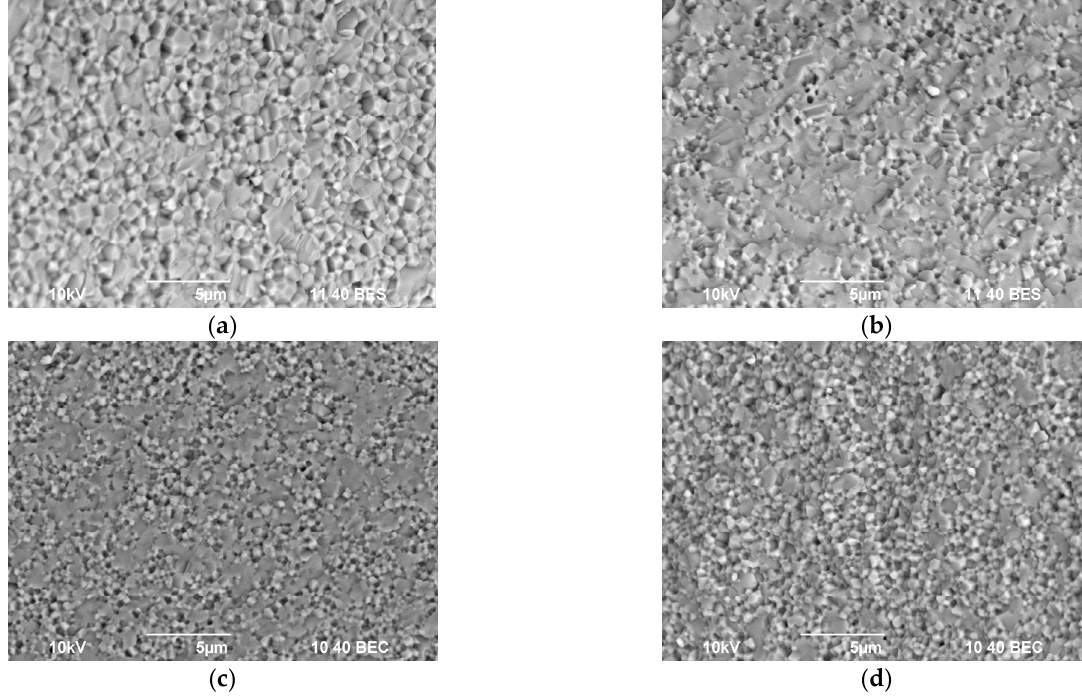
Figure A2. Fracture surfaces of α -Al 2 O 3 + 0.5%vol. MgO samples obtained at Т = 1520 °C at 10